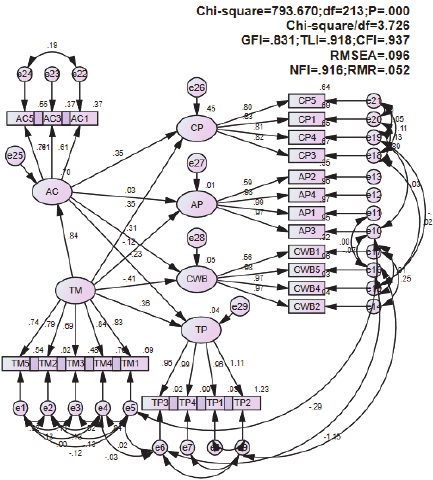
Fig . 2 . SEM shows the relationship between the factors (following standardized coefficients)